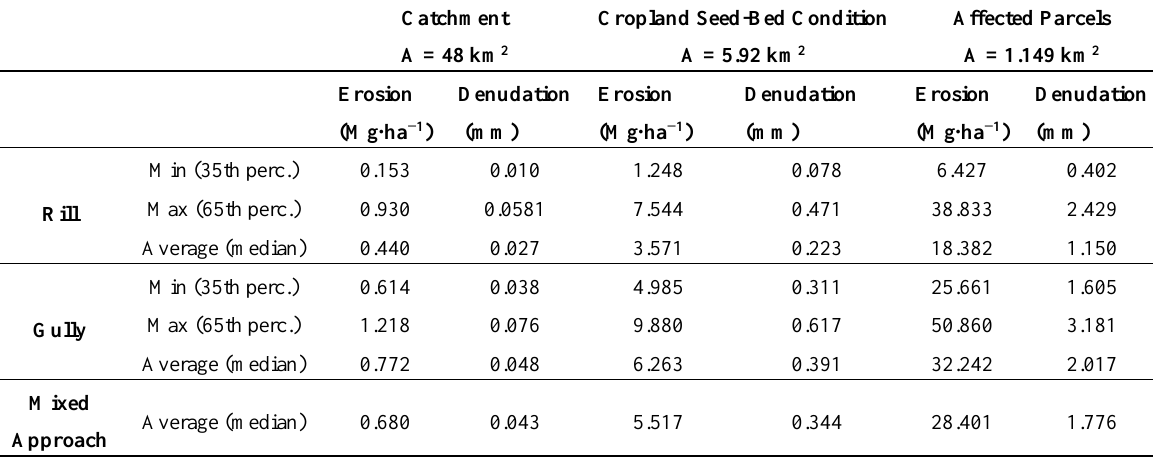
Table 5. Erosion in Mg∙ha −1 and denudation in mm for the entire catchment (total surface area: 48 km 2 ), cropland/seed-bed conditions (5.92 km 2 ) and the parcels that were affected by rill and gully erosion (1.149 km 2 ) based on the values of the coefficients a and b for the rills and gullies for the 35th percentile (minimum value), 65th percentile (maximum value) and median